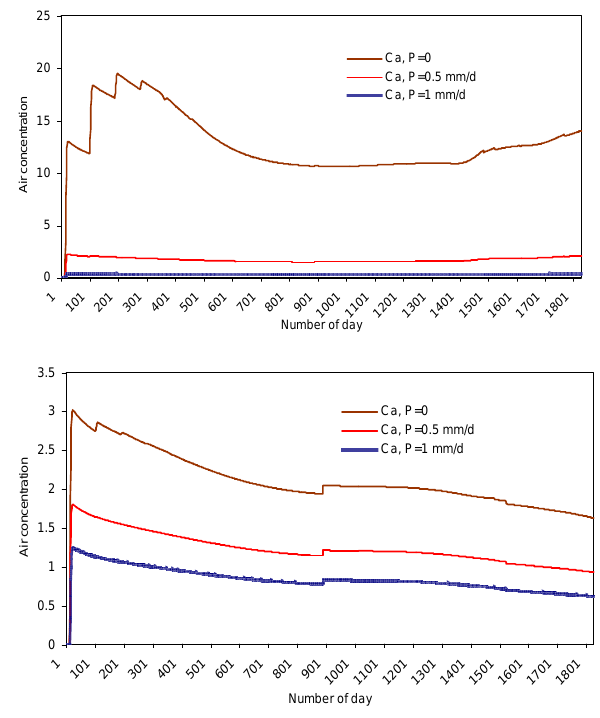
Fig. 11 Fig. 11. Daily time series of modeled air concentration (Ca) of γ - HCH at 80 ◦ N for a 5 years period from non-steady state solution of Eq. (1) responding to the precipitation scavenging at daily precipi- tation rate 0.5 and 1mmd − 1 at (a) 10 and (b) 3000m